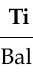
Table 1. The chemical composition (in wt./%) of the pre-alloyed Ti64 powder. Ti Al V Fe Other Elements Bal. 6.44 4.15 0.19